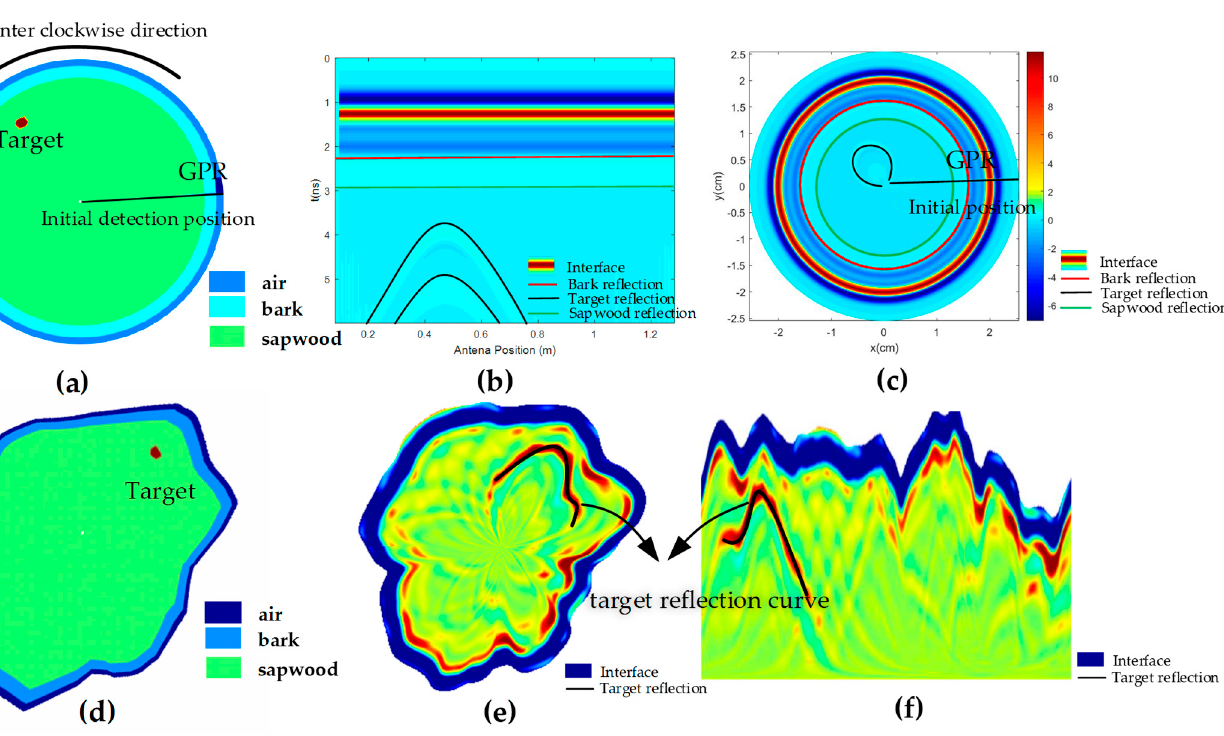
Figure 10. Forward simulation of a single target with different detection boundaries. ( a ) Regular trunk model; ( b ) reflection pattern of the regular model; ( c ) radar image in the circular domain; ( d ) irregular trunk model; ( e ) radar image of the actual trunk after the image affine transformation; ( f ) radar images in the physical domain.